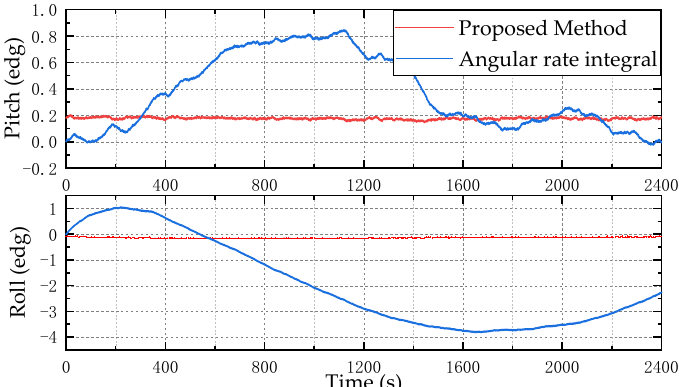
Figure 9. Static hardware-in-the-loop simulation test results. The top is the pitch angle result and the bottom is the roll angle result.